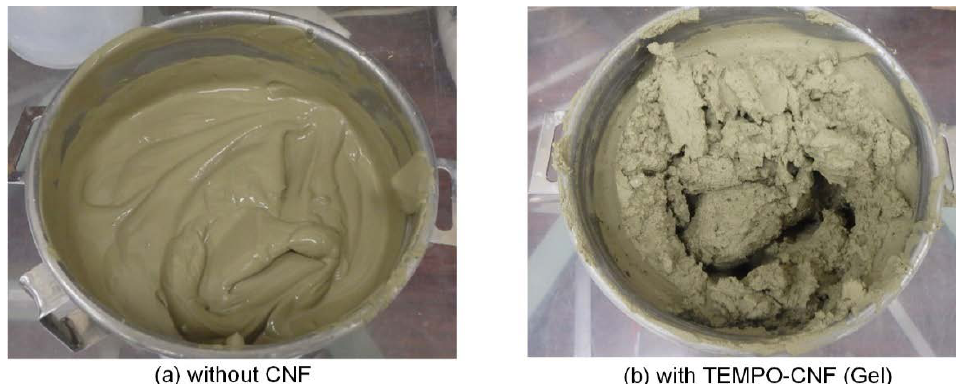
Figure 2. Appearance immediately after mixture by Method 1.